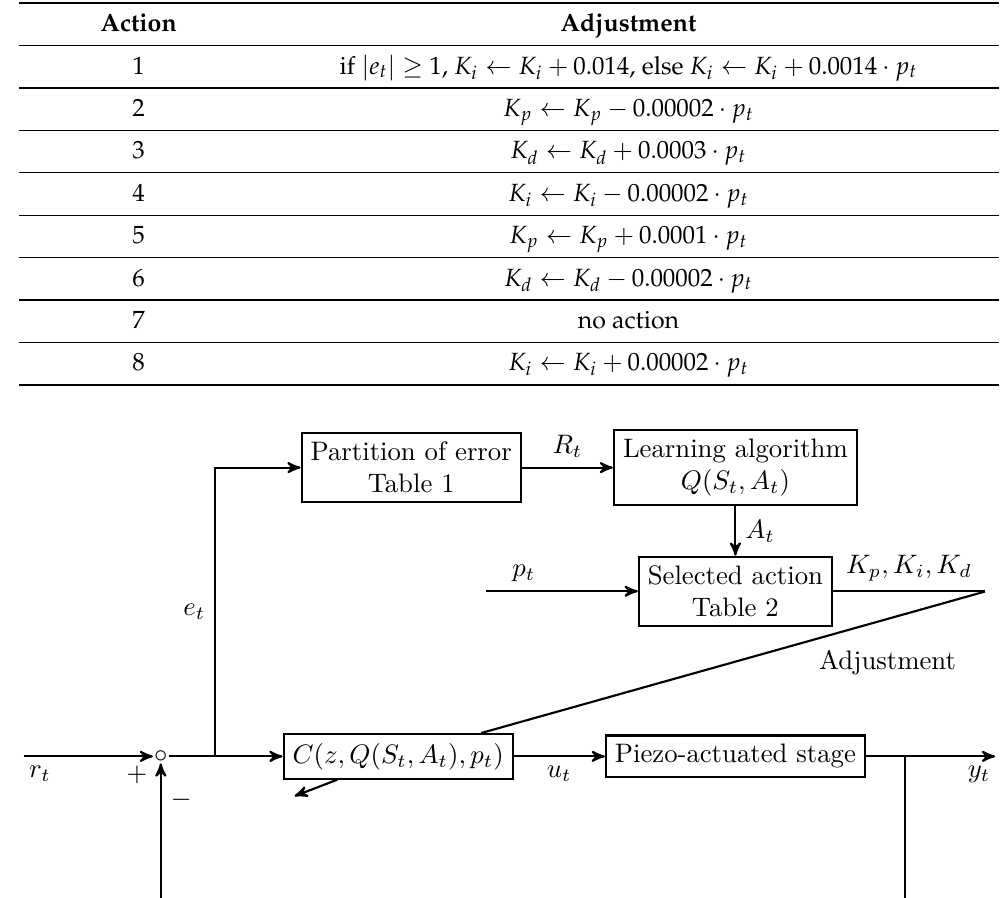
Table 2. Actions of the learning algorithm.